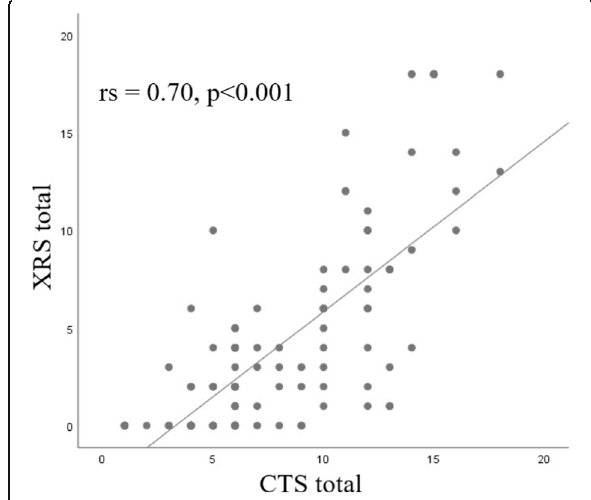
Fig. 3 Scatter plot graph of the correlation between total scores. The graph shows the high positive correlation between total CTSs and XRSs (rs = 0.70, p < 0.001). CTS computed tomography score; XRS X-ray score